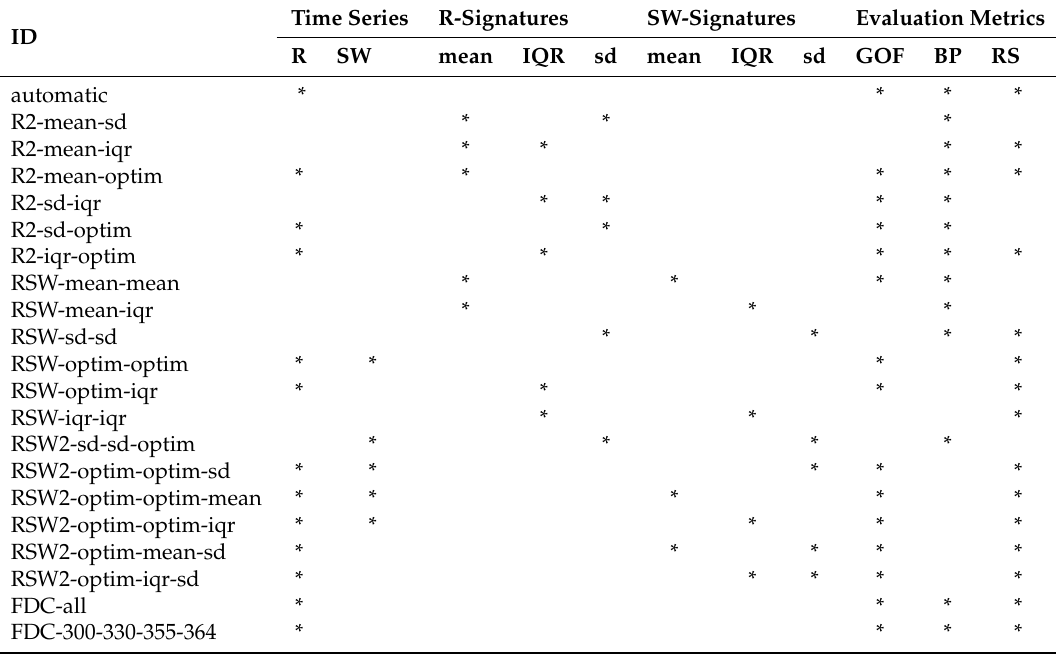
Table 5. The best OFs according to goodness-of-fit (GOF), parameters of the hydrological model (BP) and high and low flow indices (RS). Time series, R-signatures and SW-signatures mean characteristic which combined times series or signatures of runoff (R) and of soil moisture (SW), their statistic indicators are mean, interquartile range (IQR), sd and selected settings (*). Time Series R-Signatures SW-Signatures Evaluation Metrics ID R SW